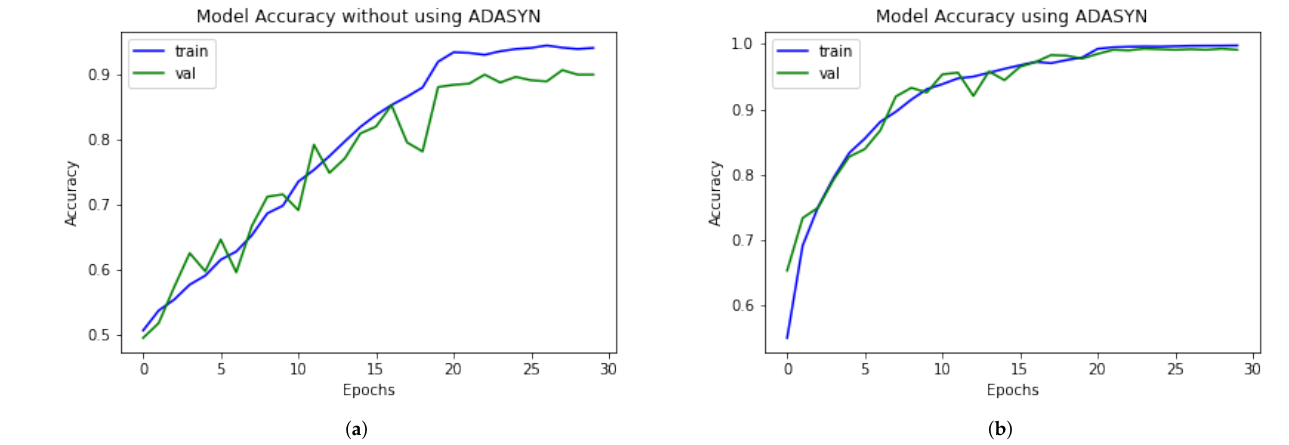
Figure 10. Self-comparison of the accuracy of proposed DAD-Net With and without using ADASYN up-sampling algorithm. ( a ) Proposed DAD-Net without ADASYN; ( b ) Proposed DAD-Net with ADASYN.